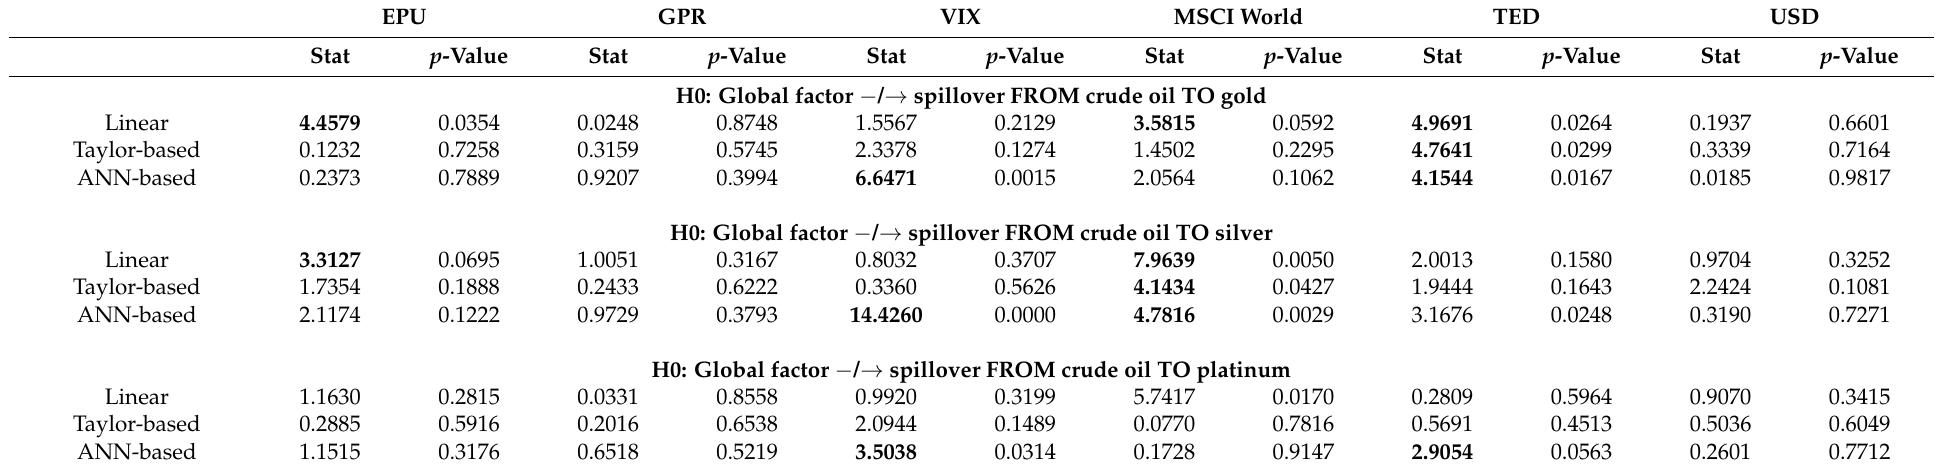
Table 5. Linear and nonlinear causality tests for spillovers from oil to individual commodity uncertainties (GFC